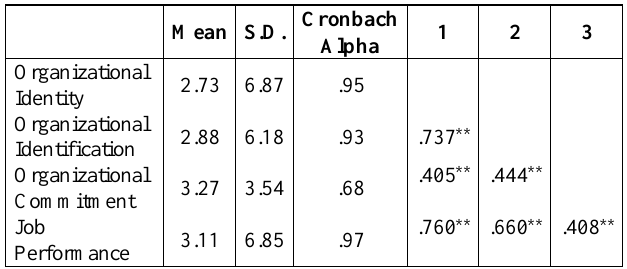
Table 4: The Results of the Regression Analysis for the Relationship between OI, OID, OC and